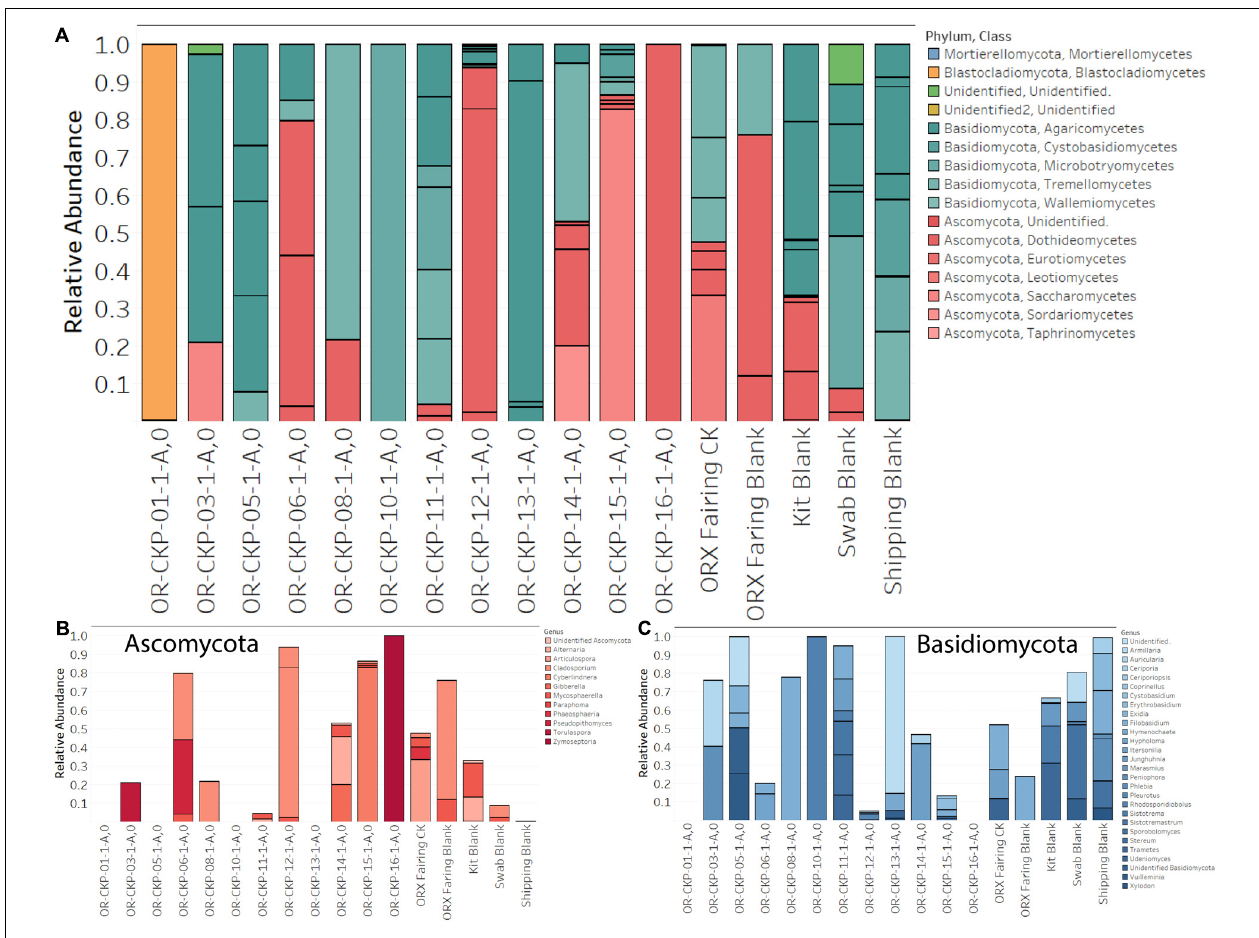
FIGURE 6 | Fungal sOTUs identified in each sample (A) . sOTUs are colored by pyhlum and class. Most samples are dominated by sequences belonging to Basidomycota (blue bars; A,C ). Samples 6, 12, 15, and 16 are dominated by Ascomycota (red bars; A,B ). Abundant phyla are plotted at the genus level in (B,C) .